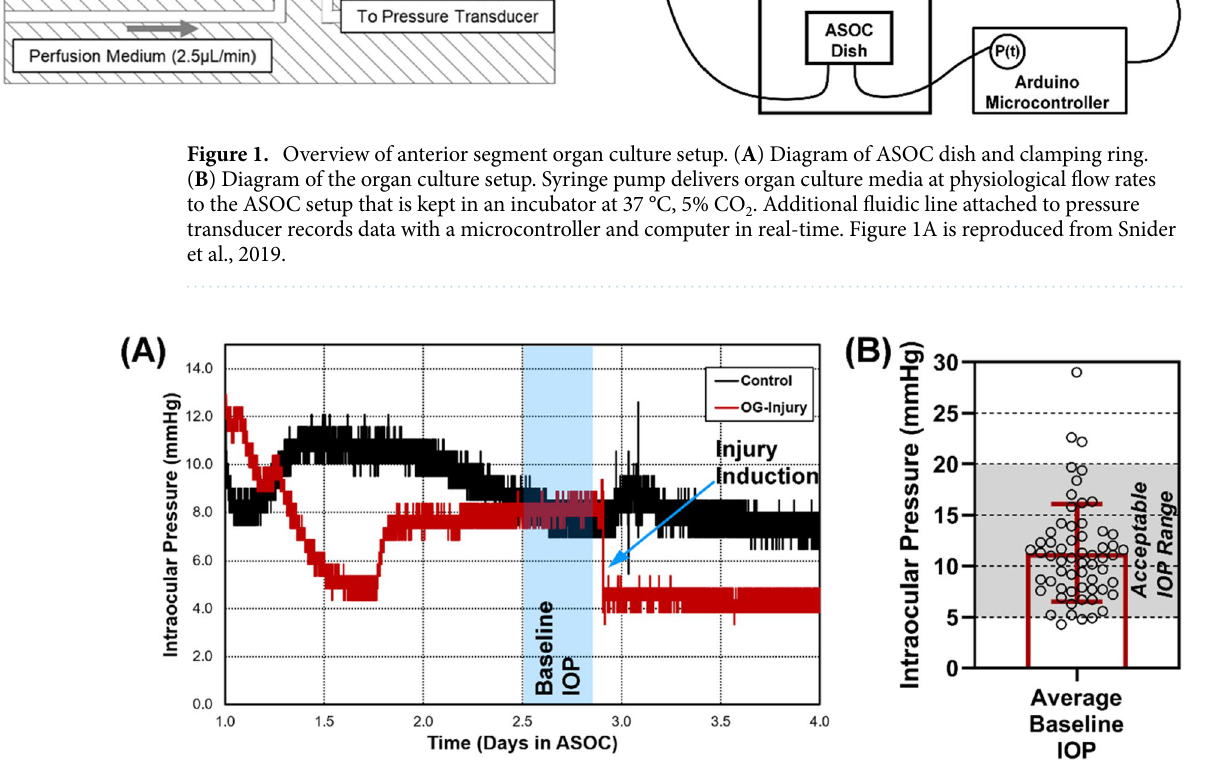
Figure 2. Intraocular pressure results for anterior segment organ culture. ( A ) Representative data showing IOP traces across the ASOC setup. Region where IOPs were averaged to determine baseline IOP, defined as the region immediately prior to OG injury, is shown. ( B ) Stabilized IOP for all ASOC experiments, with 6 experiments falling outside the acceptable IOP range, 5 to 20 mmHg 17